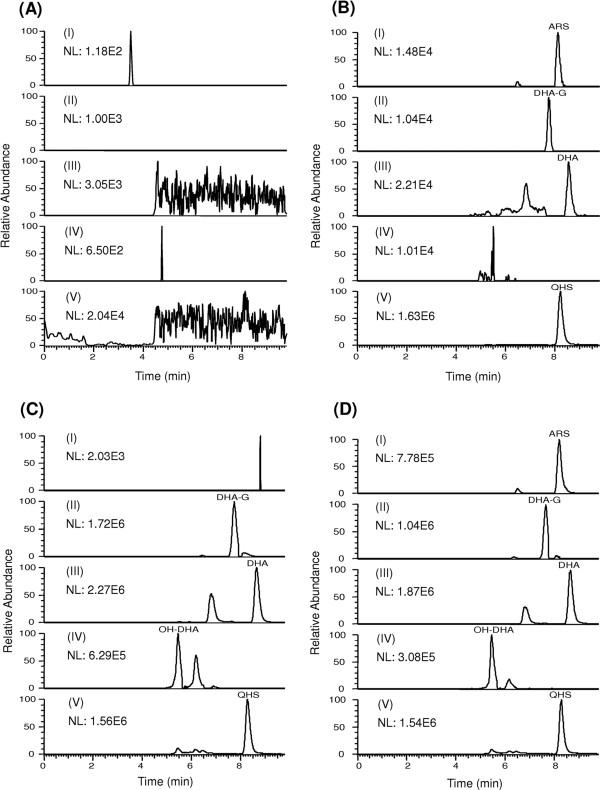
Representative full-scan chromatograms of (A) a blank rat plasma sample; (B) a blank rat plasma sample spiked with dihydroartemisinin (DHA; 10 nM), artesunate (ARS; 10 nM), the glucuronide of DHA (DHA-G; 20 nM) and IS (QHS, 4 μM); (C) a rat plasma sample at 0.17 h after a single oral dose of DHA (10 mg/kg); and (D) a rat plasma sample at 0.17 h after a single oral dose of ARS (10 mg/kg). I: ARS (m/z402.2122); II: the glucuronide of DHA (m/z478.2283); III: DHA (m/z302.1962); IV: the monohydroxylated metabolite of DHA (M1;m/z318.1911); V: IS (m/z283.1540).